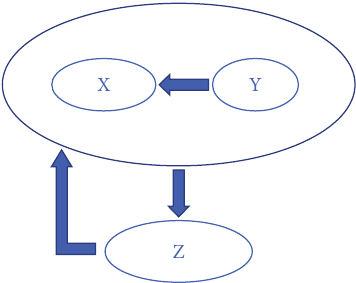
Figure 4: Schematic diagram of trade creation e ff